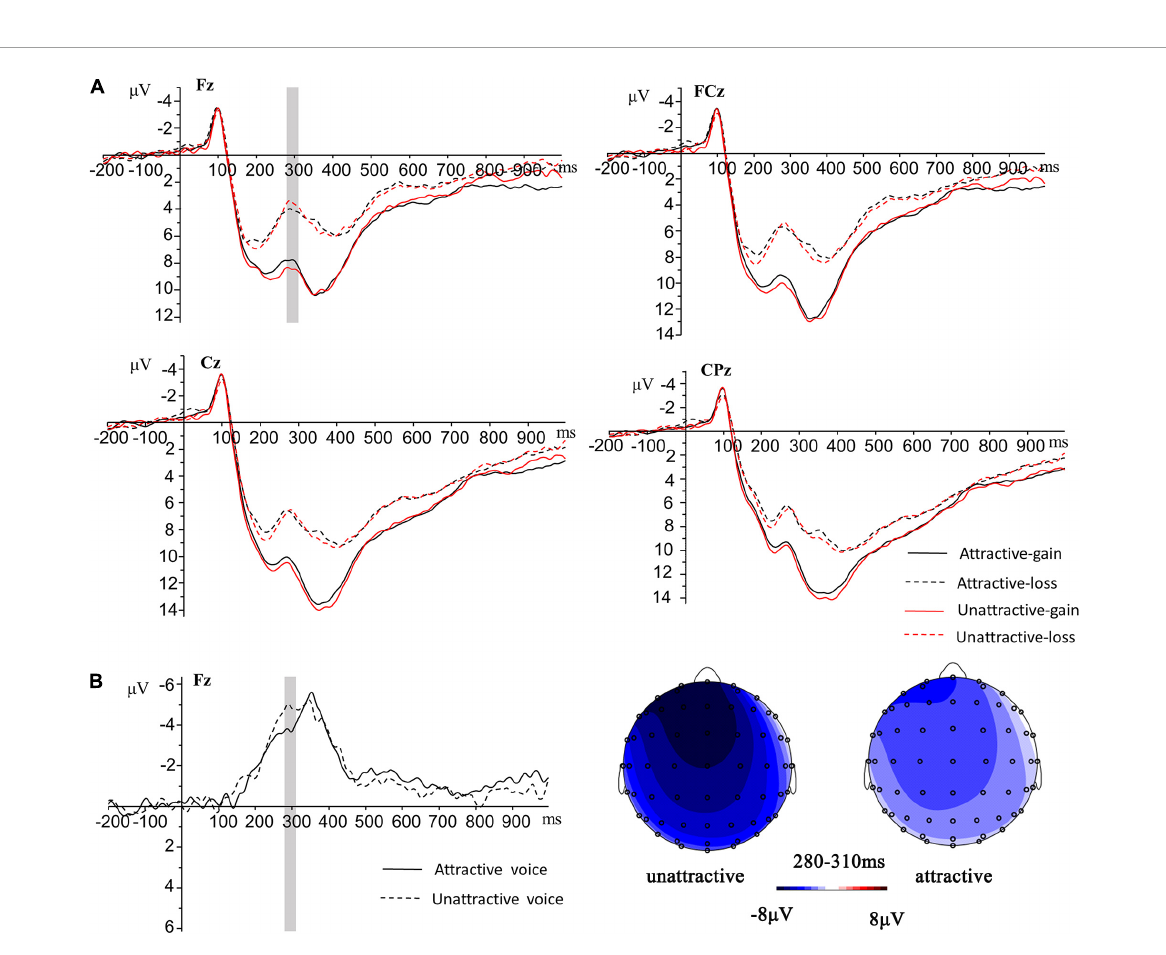
FIGURE2 (A) Grand average event-related potentials (ERPs) induced by feedback of gain and loss at four representative electrodes in the attractive and unattractive voice conditions. (B) Topography of scalp distribution and differential waves generated by gain and loss in the attractive and unattractive voice